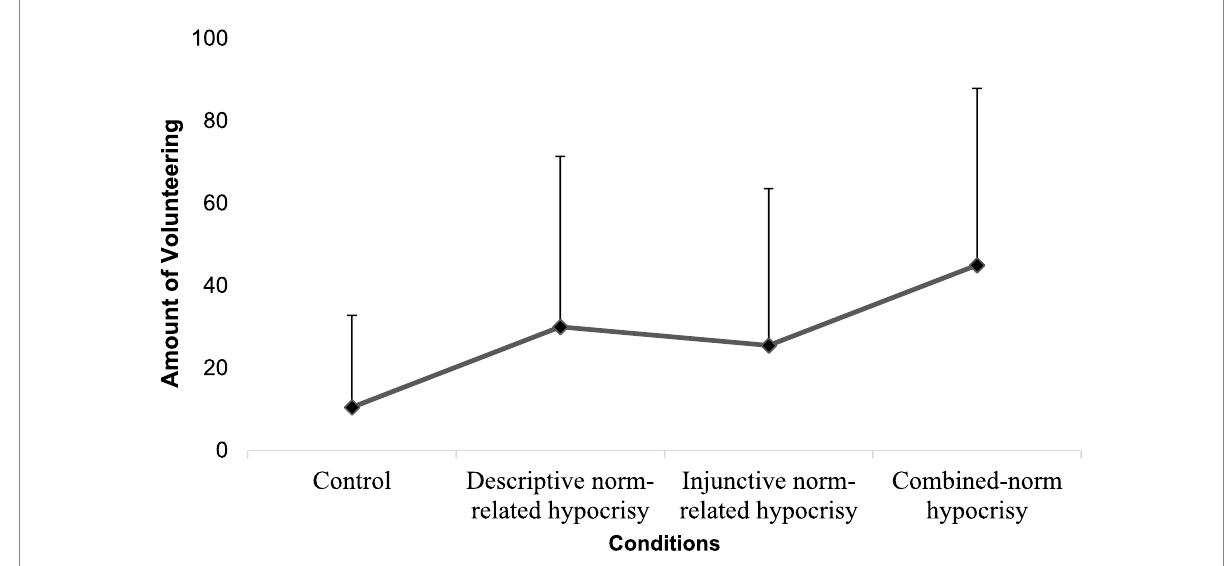
FIGURE 2 Participants’ amount of volunteering. Volunteering of participants is shown for the four experimental conditions ( N = 80). Volunteering was measured by asking participants how much time they were willing to give to a discrimination prevention association. Volunteering is in minutes and error bars show standard